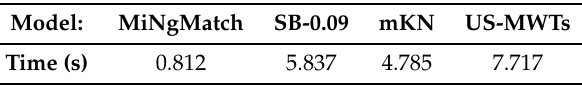
Table 16. Execution times in